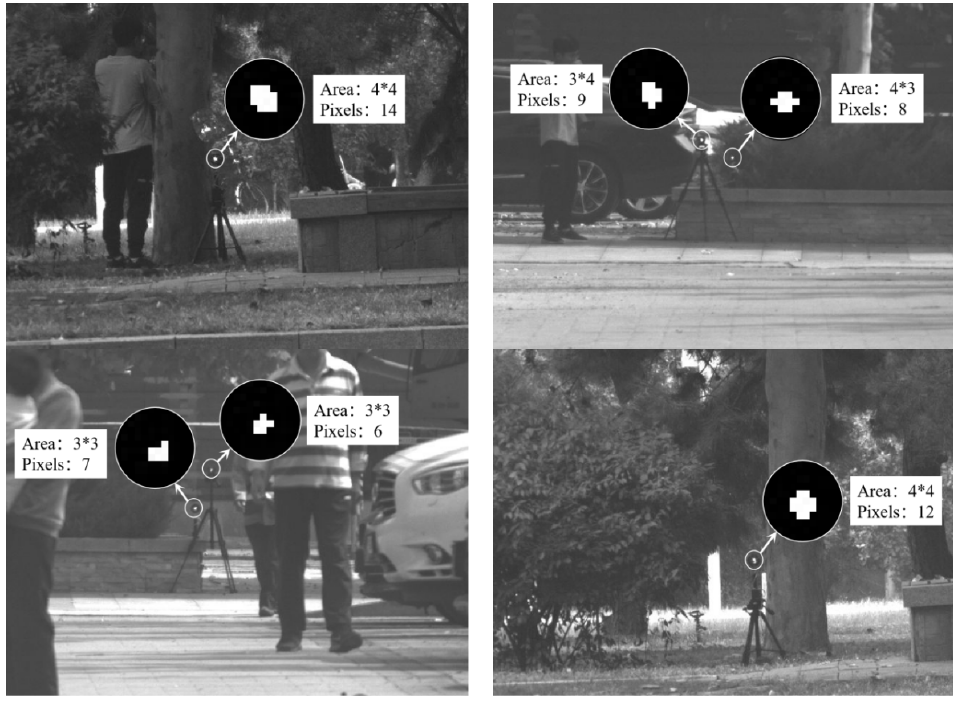
Figure 7. Photoelectric device echo shape.